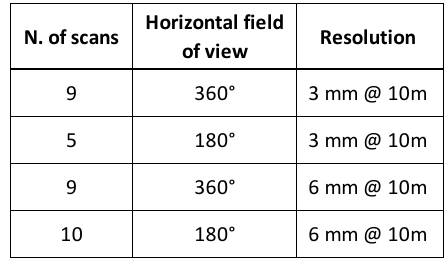
Table 1. Faro scans with different settings of the horizontal field of view and resolution